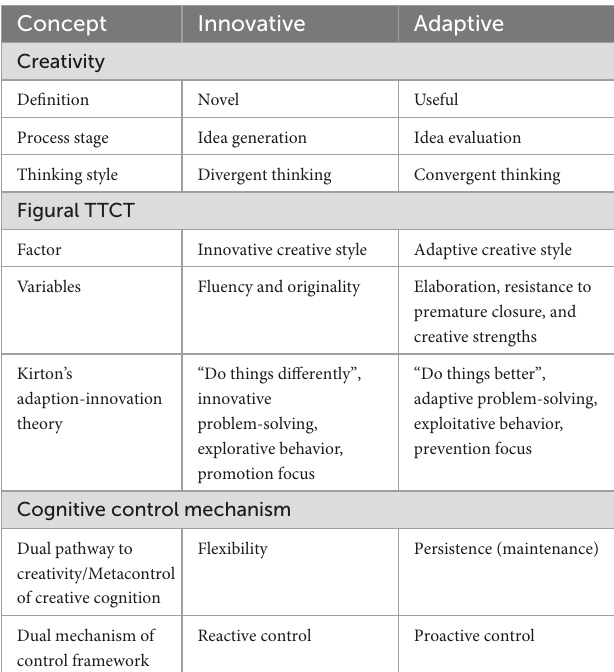
TABLE 1 Definitions, concepts, and frameworks/models connected to innovative-adaptive